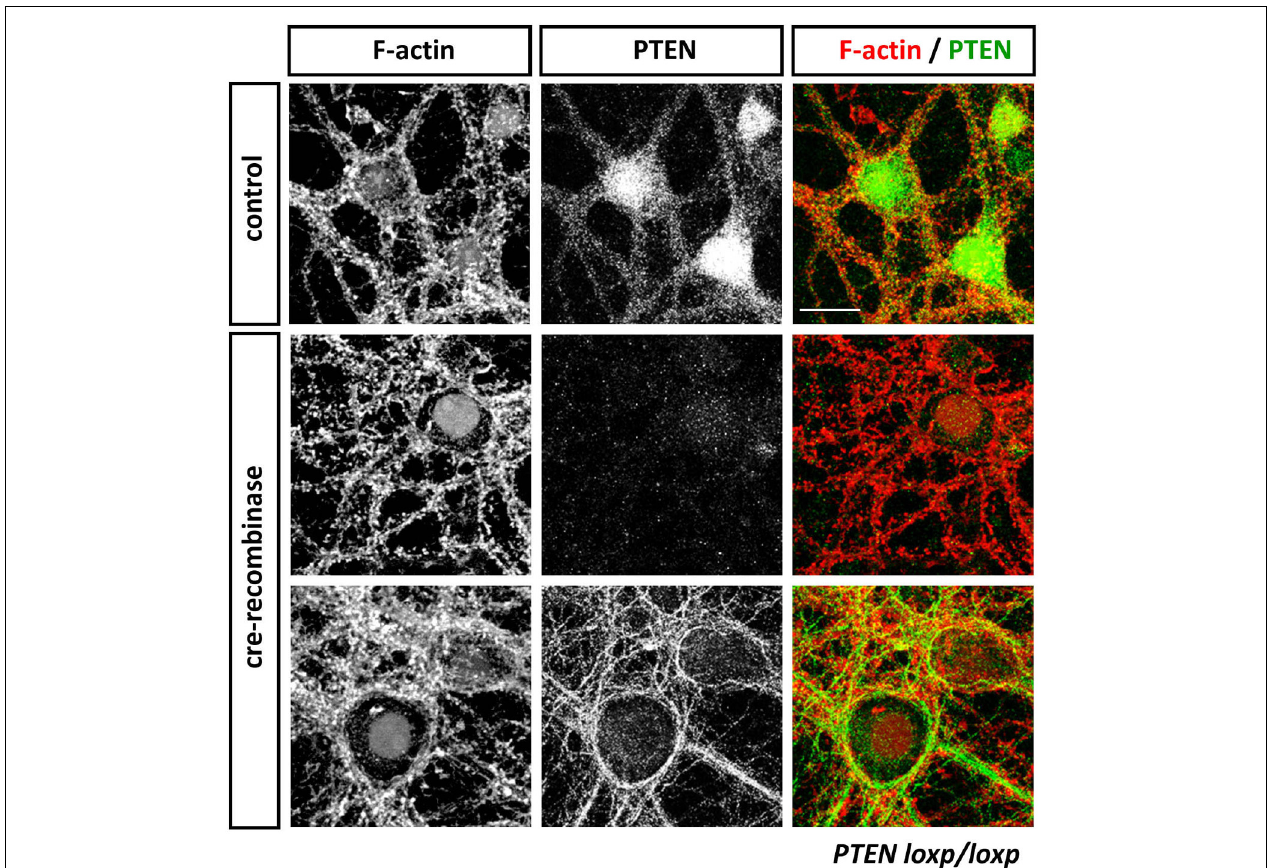
FIGURE 3 | Anti-PTEN antibodies do not always faithfully report on subcellular distributions of PTEN. Cortical neurons isolated from PTEN flox / flox mice were transduced with control or Cre-expressing viruses at 13 days in vitro (DIV). Neurons were fixed with 4% parafolmaldehyde at 25DIV, permeabilized with 0.1% Triton X-100 and stained with Phalloidin to visualize F-actin and anti-PTEN antibodies 138G6 (rabbit monoclonal from Cell Signaling Technology) and A2B1 (mouse monoclonal from Santa Cruz Biotechnogy). PTEN as detected with 138G6, (1:400 dilution) is highly enriched in the neuronal soma and dendrites, but it is largely absent in